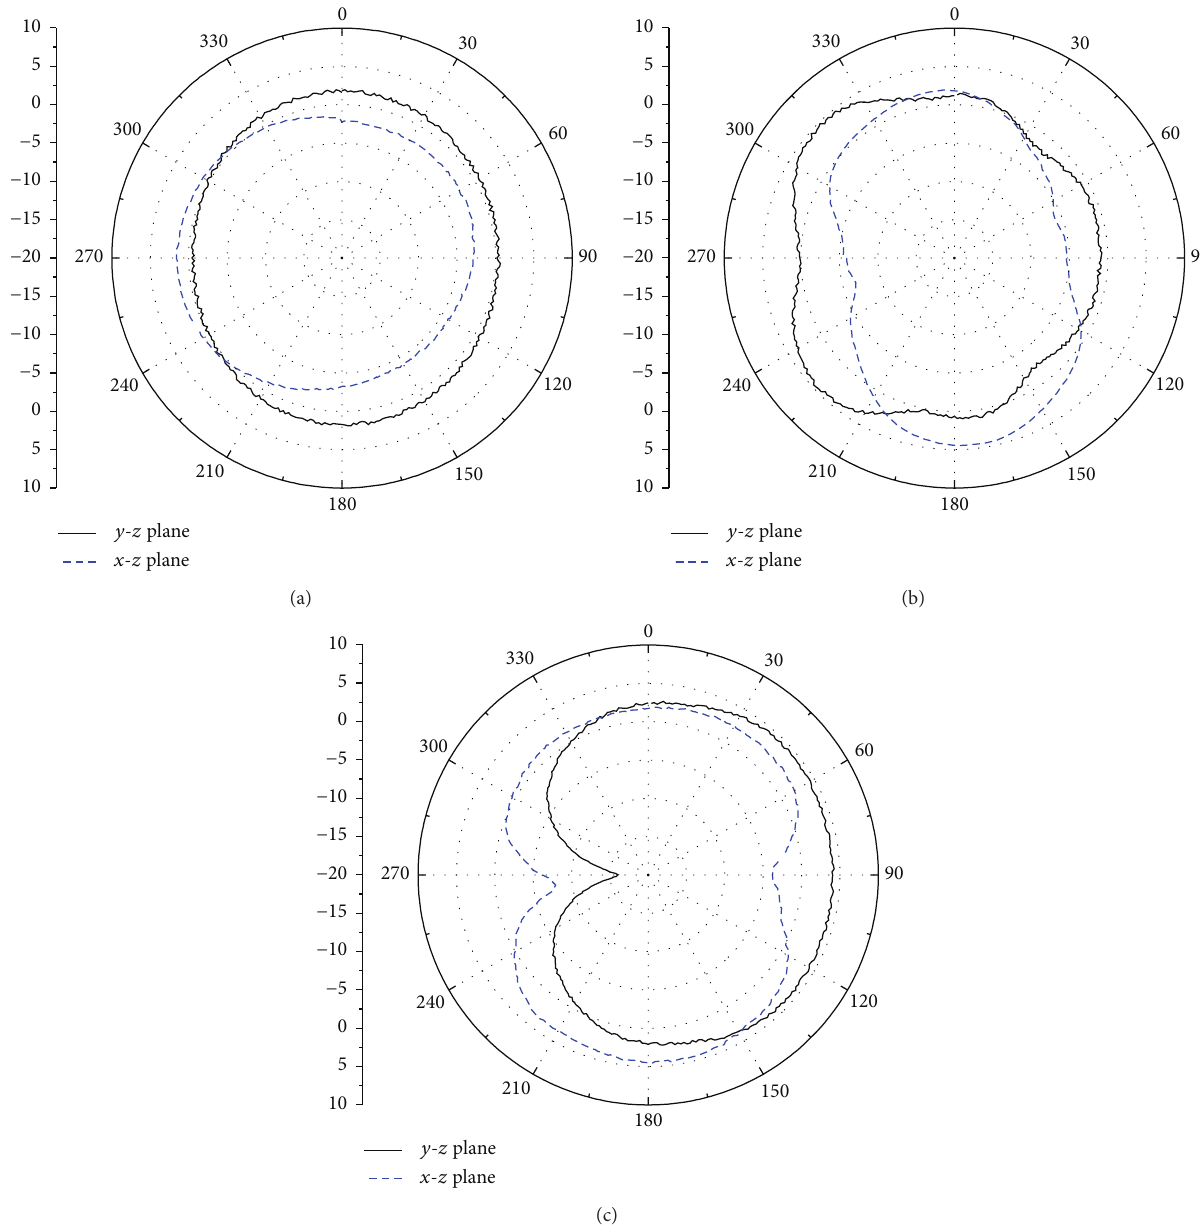
Figure 10: Measured radiation patterns of the proposed antenna for the LTE operation frequencies at (a) 0.75 GHz; (b) 2.6 GHz; and (c) 3.5